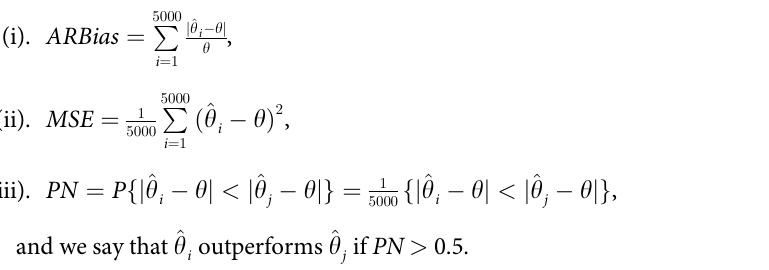
Table 2. Absolute relative bias ( ARBias ) and MSE (in parentheses) of ^ θ with theoretical value of θ < 0.5. ( α 1 , α 2 , θ )